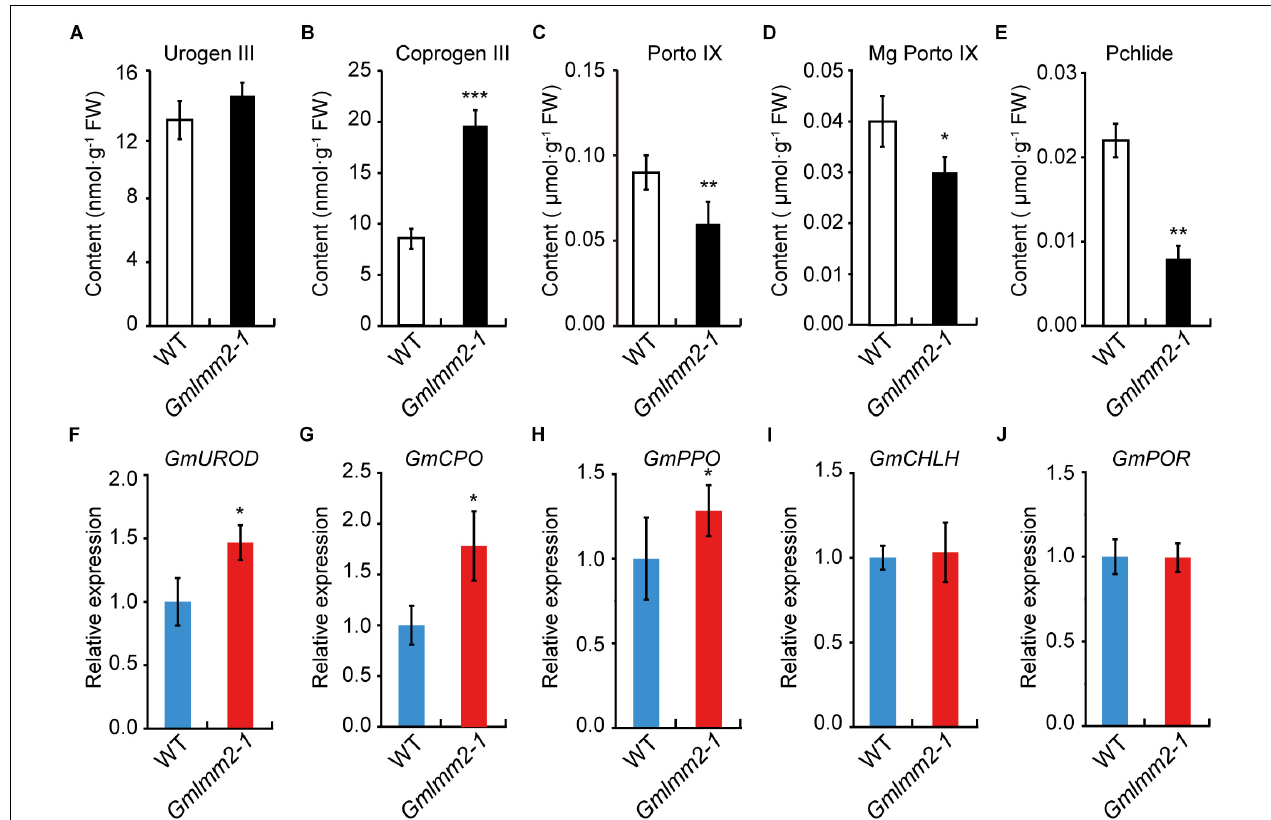
FIGURE 4 | (A–E) Contents of metabolic intermediates in young leaves of wild type and mutant. (F–J) Expression levels of some enzymes in tetrapyrrole biosynthesis of wild type and mutant. Asterisks indicate a significant difference by student’s t -test (* P < 0.05, ** P < 0.01, *** P < 0.001) and the error bars represent standard